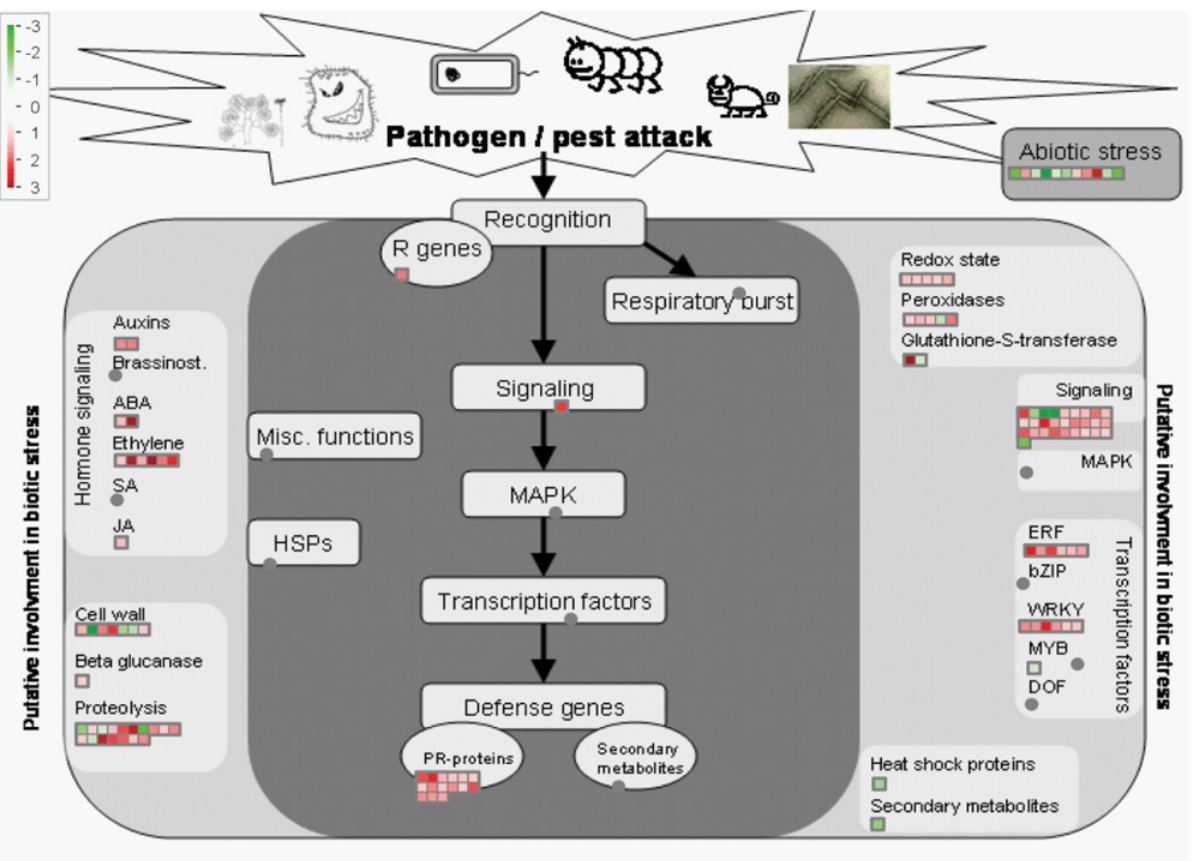
Fig 4. Mapman analysis of genes differentially regulated in gcr1 mutant. Out of the total list of 350 DEGs, 119 mapped onto biotic stress response. The red dots represent the up-regulated genes, green dots represent the down-regulated genes and the grey dots represent the genes to which none of the DEGs were assigned. The level of differential regulation is according to the scale